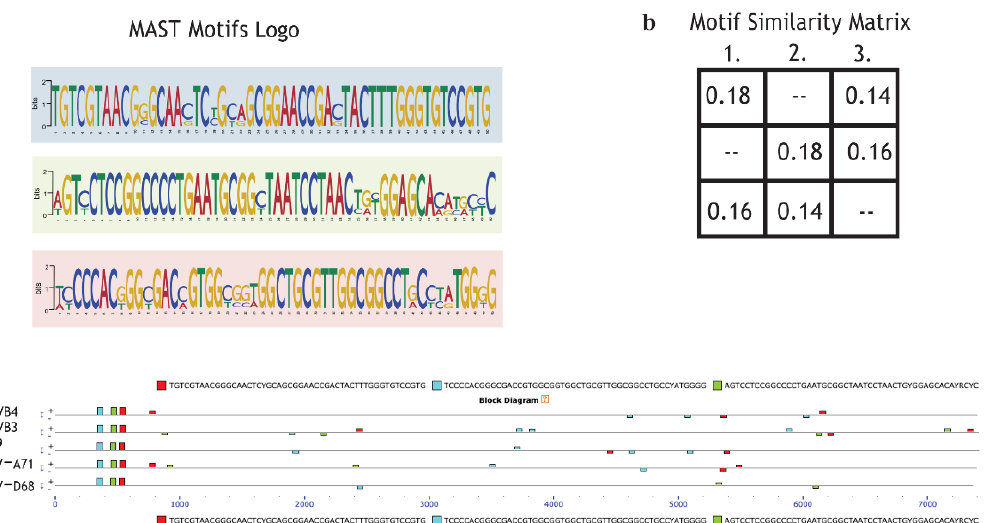
Figure 5. Motif de novo sequences: Motif logo of repetitive elements present in the genome of CVB4, CVB3, E9, EV-A71, and EV-D68. ( a ); Motif similarity matrix computes the pairwise correlations between each pair of motifs. The correlation between two motifs is the maximum sum of Pearson’s correlation coefficients for aligned columns divided by the width of the shorter motif. The maximum is found by trying all alignments of the two motifs ( b ). ( c ) Graphical representation of all virus genomes and the presence of motifs with the respective position across the genome.